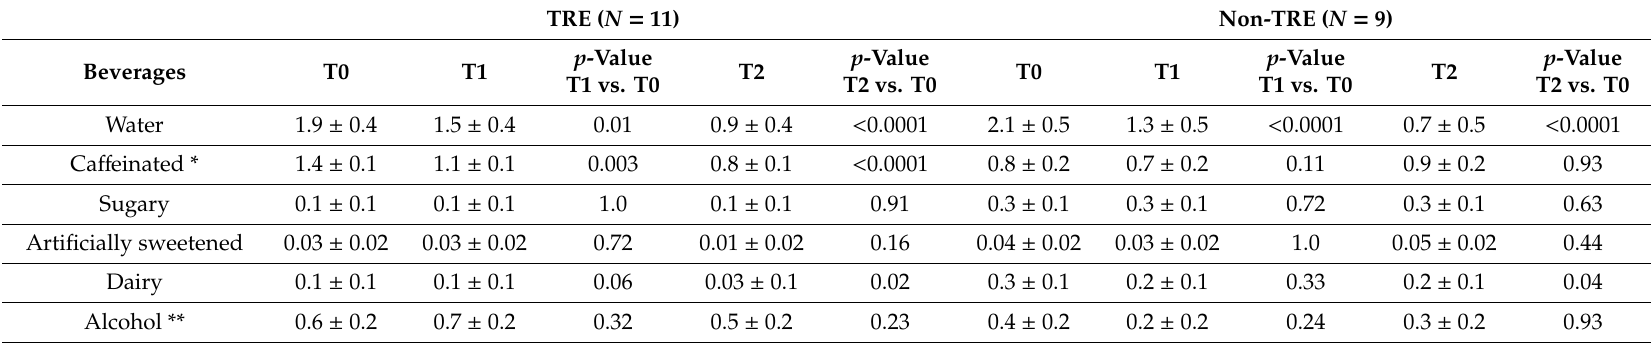
Table 3. Frequency of beverages types at T0, T1, and T2 in the TRE and non-TRE